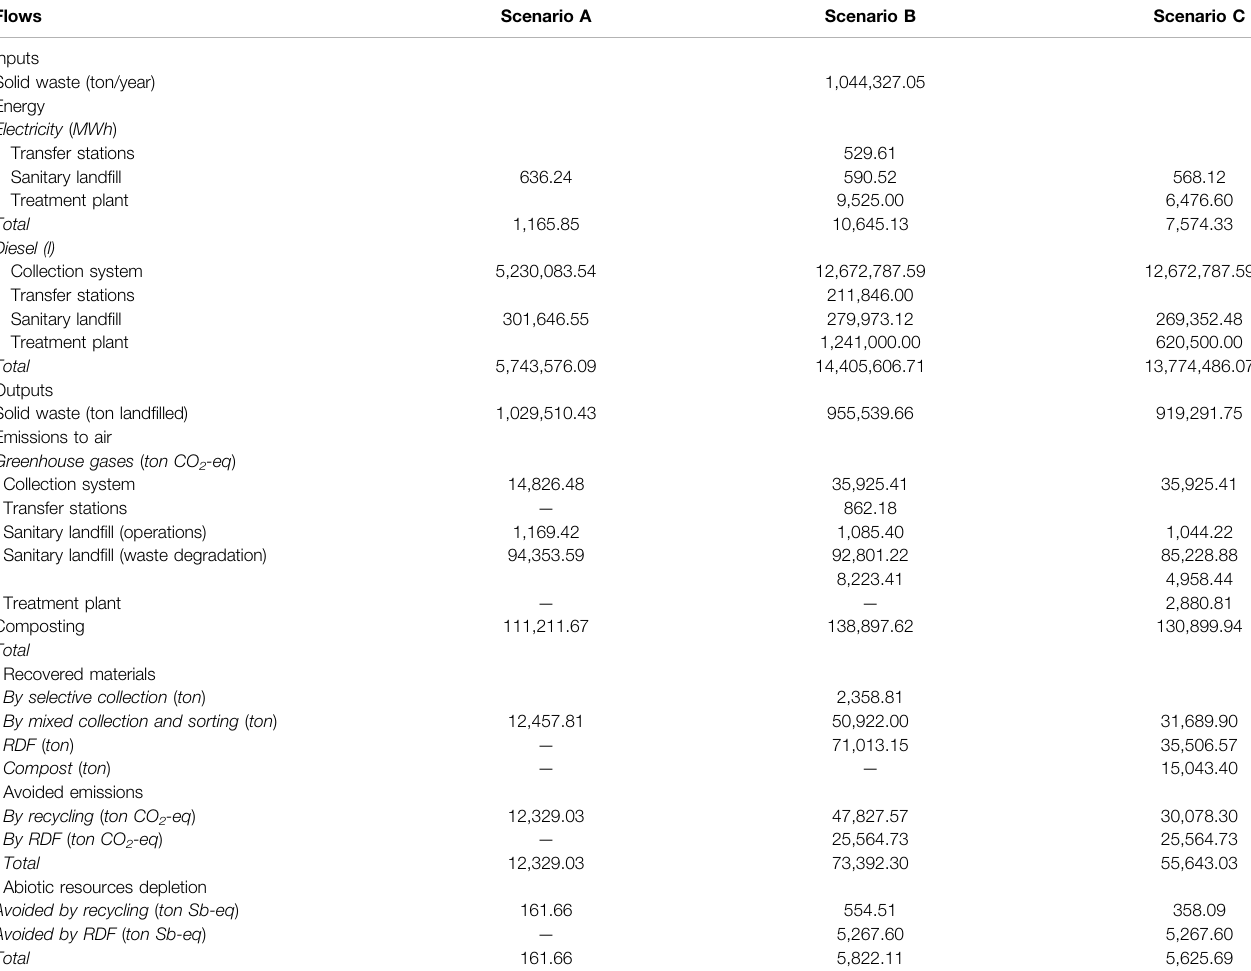
TABLE 4 | LCI - Balance of system for the management of the annual GMA MSW generation in each scenario.